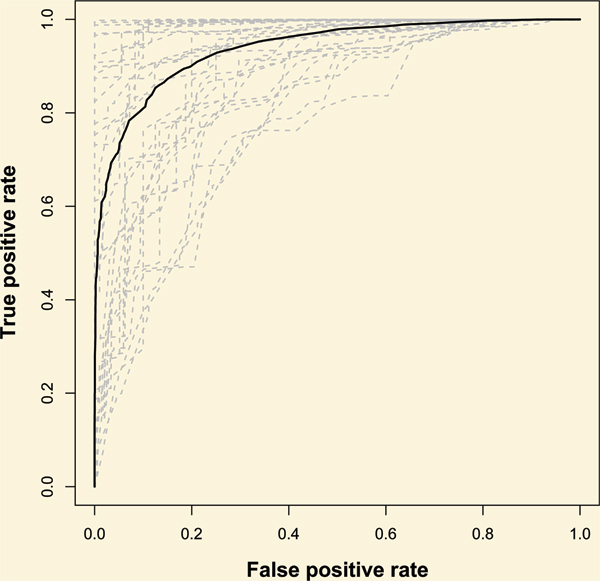
ROC-curves for 32000 simulated sequences. Solid line represents the ROC curve of IGHD identification derived from the 32000 sequences at gene level. There are 32 dashed lines (32 IGHD segments), each representing a ROC curve for the 1000 simulated sequences generated from one IGHD gene. X axis indicates (1-specificity); y axis indicates sensitivity.